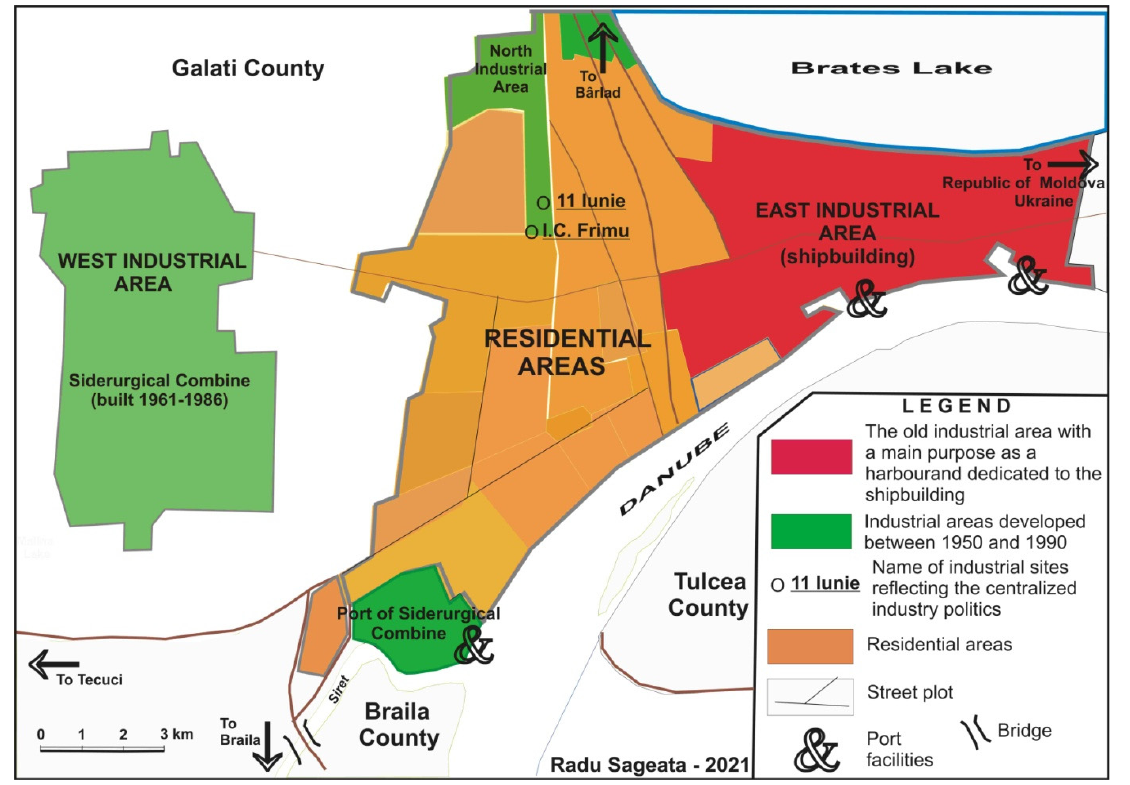
Figure 2. Industrial areas in Gala ţ i.